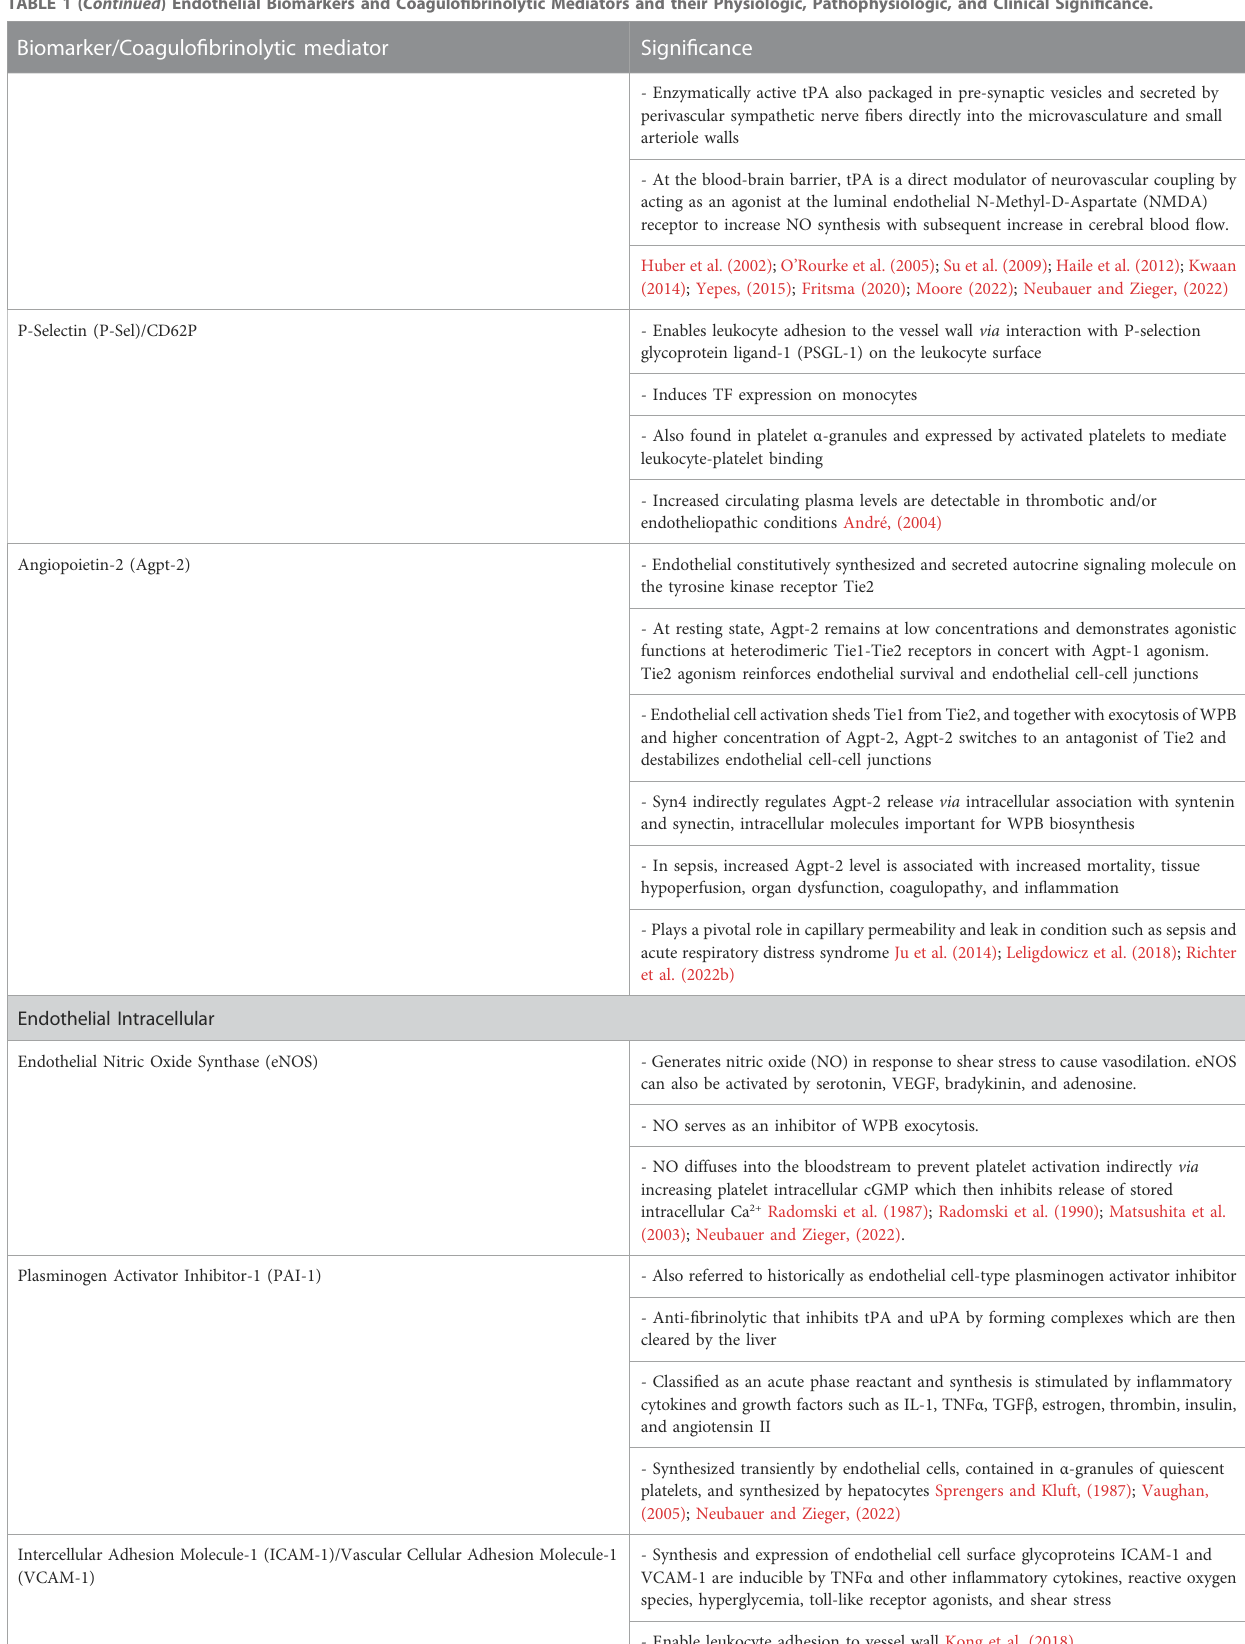
TABLE 1 ( Continued ) Endothelial Biomarkers and Coagulo fi brinolytic Mediators and their Physiologic, Pathophysiologic, and Clinical Signi fi